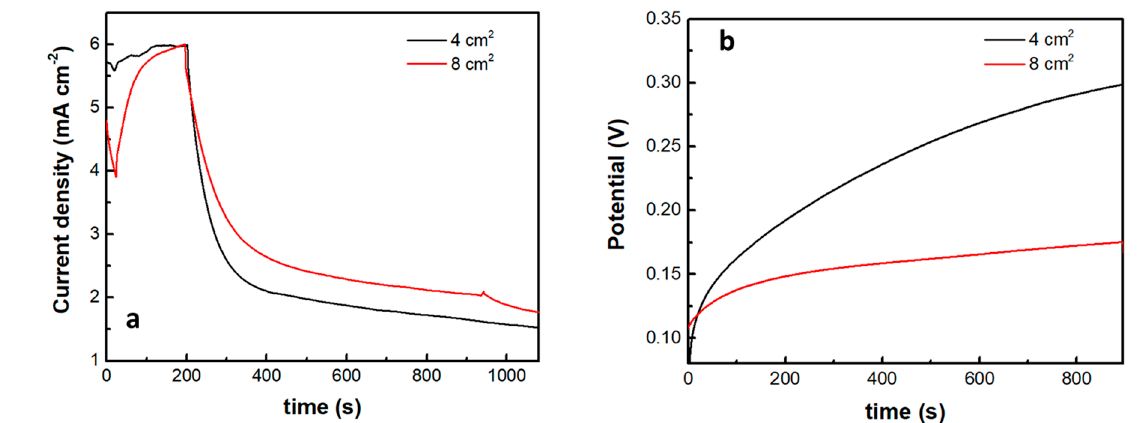
Figure 8. Current or voltage variation in the cell when light is turned off: ( a ) potentiostatic current drop at 0.4 V and ( b ) galvanostatic voltage increase at a current density of 1 mA cm − 2 . The insert gives the capacitor geometric area in each case.